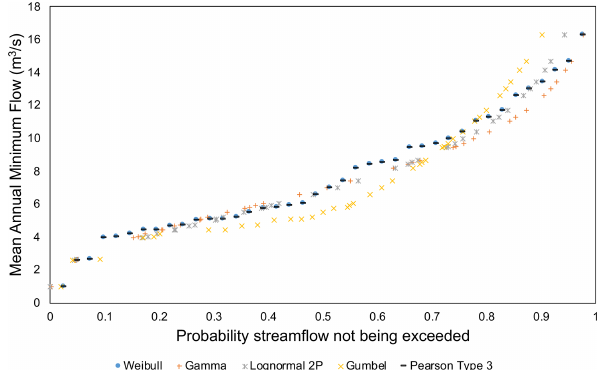
Figure 4. Probability of mean annual minimum flow for station